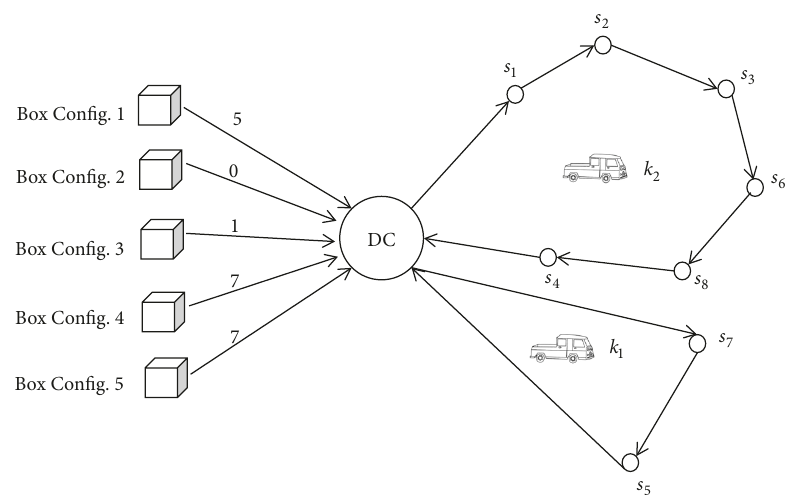
Figure 2: Delivery number for different box configurations and optimal route of two trucks.